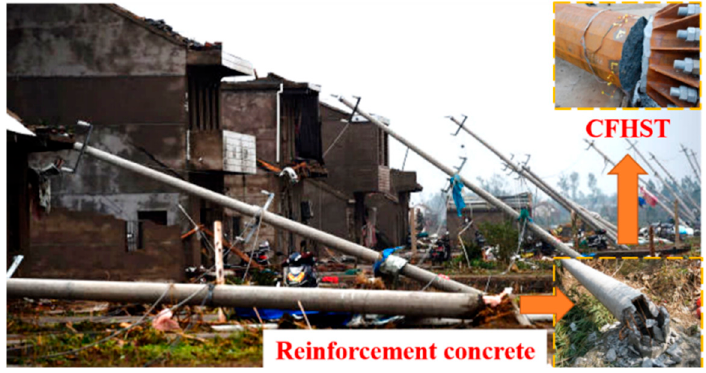
Figure 1. Transmission pole tower collapse.